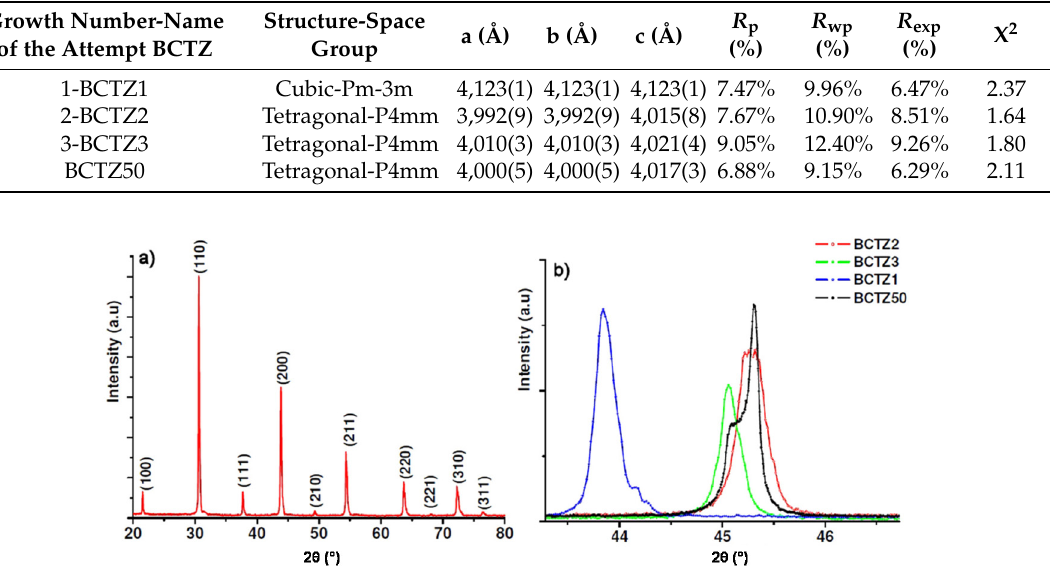
Figure 5. ( a ) X-ray powder diffraction pattern of the crushed as-grown BCTZ1 single crystal recorded at room temperature; and ( b ) shift of the position of the (200) pc diffraction peak showing an increase of the unit cell volume in BCTZ1 compared to BCTZ50 composition. The lattice parameters were calculated using a Rietveld global profile-matching method. Although BCTZ2 and BCTZ3 could be indexed in the tetragonal symmetry a possible coexistence of different symmetries could not be excluded in these two compositions because of anisotropic line-shape broadenings along with no well-defined peak splitting.